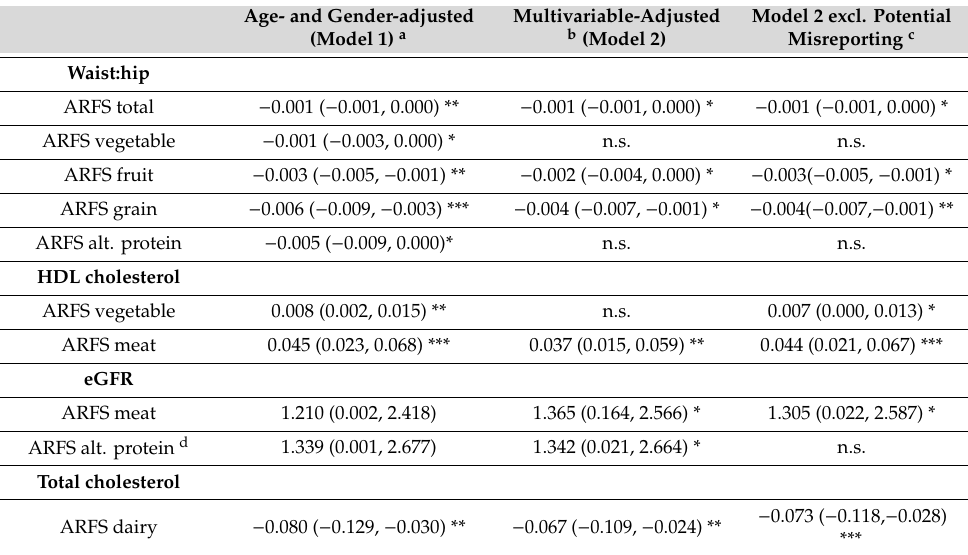
Table 4. Australian Recommended Food Scores and modifiable cardiometabolic risk factors.